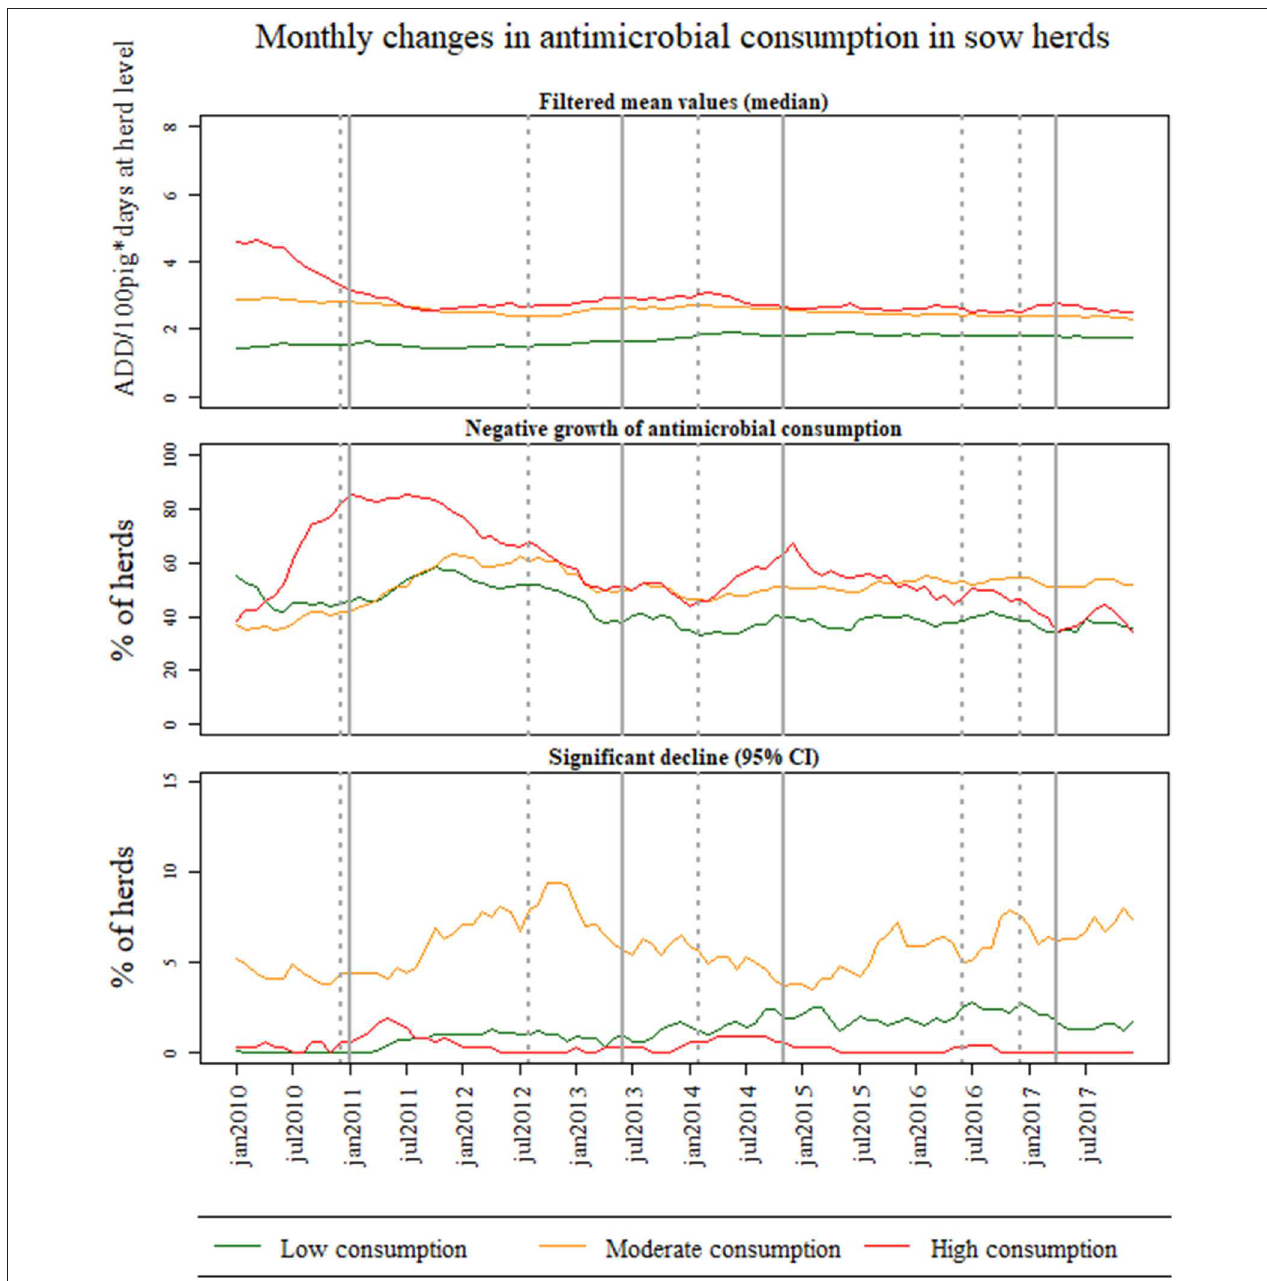
FIGURE 3 | Monthly changes in antimicrobial consumption in Danish sow herds between January 2010 and December 2017 for all Danish farms. The farms were divided into three groups based on the level of antimicrobial use (low, medium, and high) in 2008 and 2009. For each group of antimicrobial consumption, the graphs depict (1) the median of the filtered mean values obtained at farm-level based on the Dynamic Linear Model (DLM) with a linear trend component, (2) the percentage of herds with negative growth based on the DLM, and (3) the percentage of herds with a significant decline on the trend component of the DLM using 95% credible intervals